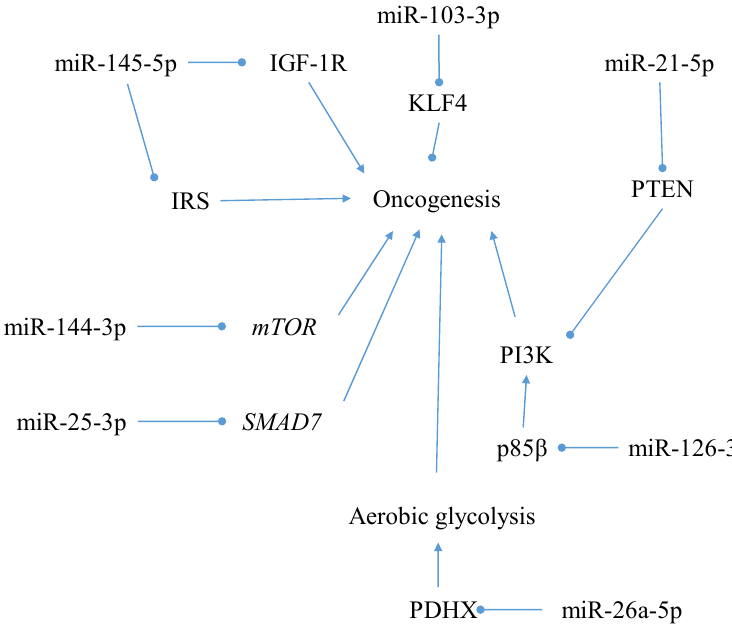
Figure 9. A diagram illustrating the interaction of miRNAs with genes and pathways regulating the pathogenesis of colorectal cancer.